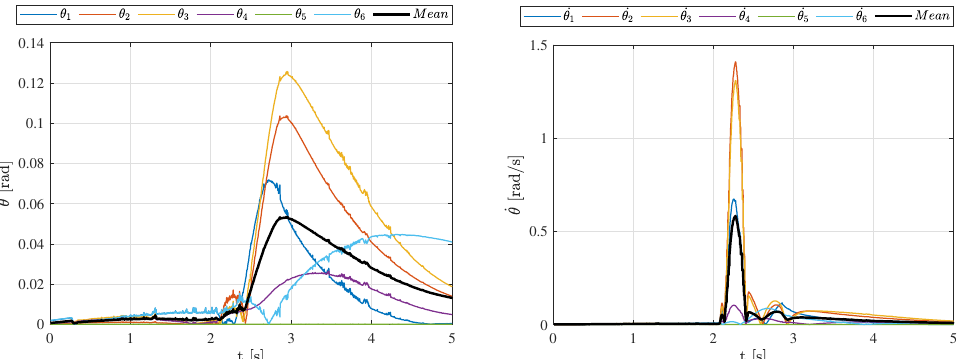
Figure 12. Test case 2, Mode II. The error between simulation and real system. Joint rotations ( left ) and joint speeds ( right ).